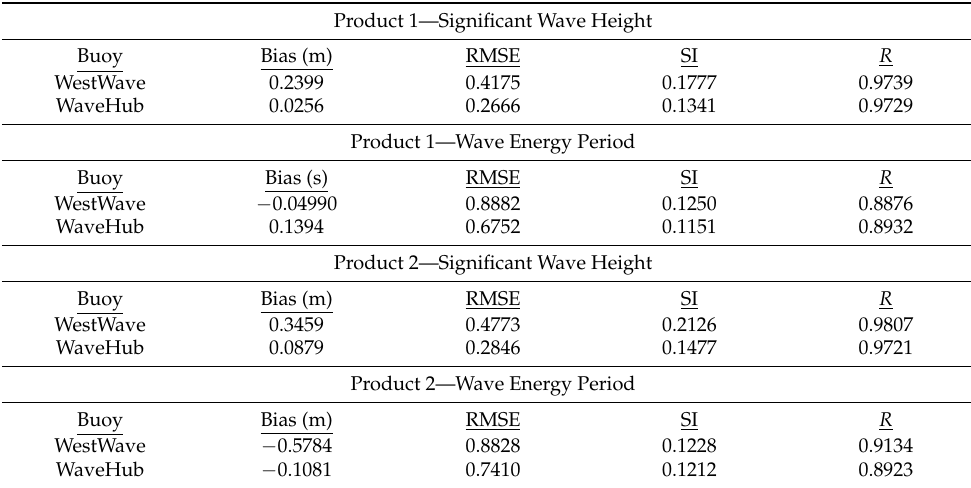
Table 11. Results of the wave model validation. Figure 24. In situ validation points with reference to the potential wave and tidal energy sites.